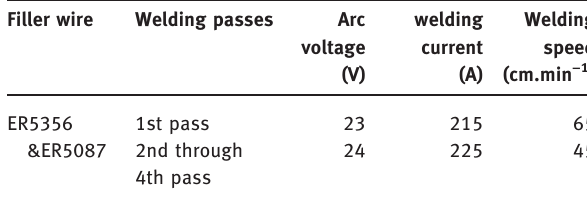
Table 3: Welding process parameters by ER5356&ER5087.